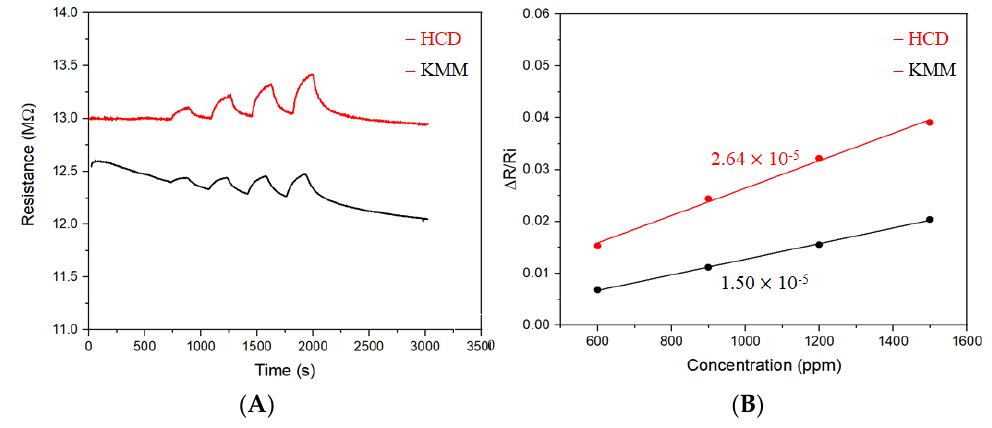
Figure 6. Response profiles ( A ) and sensitivities ( B ) of a chemiresistor sensor in response to hexane vapors of different concentrations obtained using HCD and KMM.